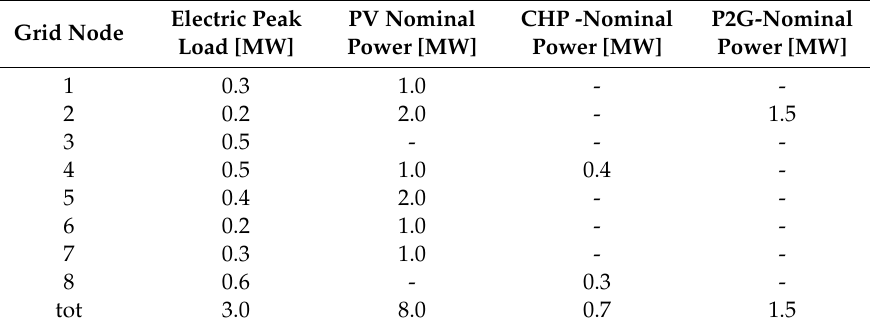
Table 1. Technologies connected to the electric